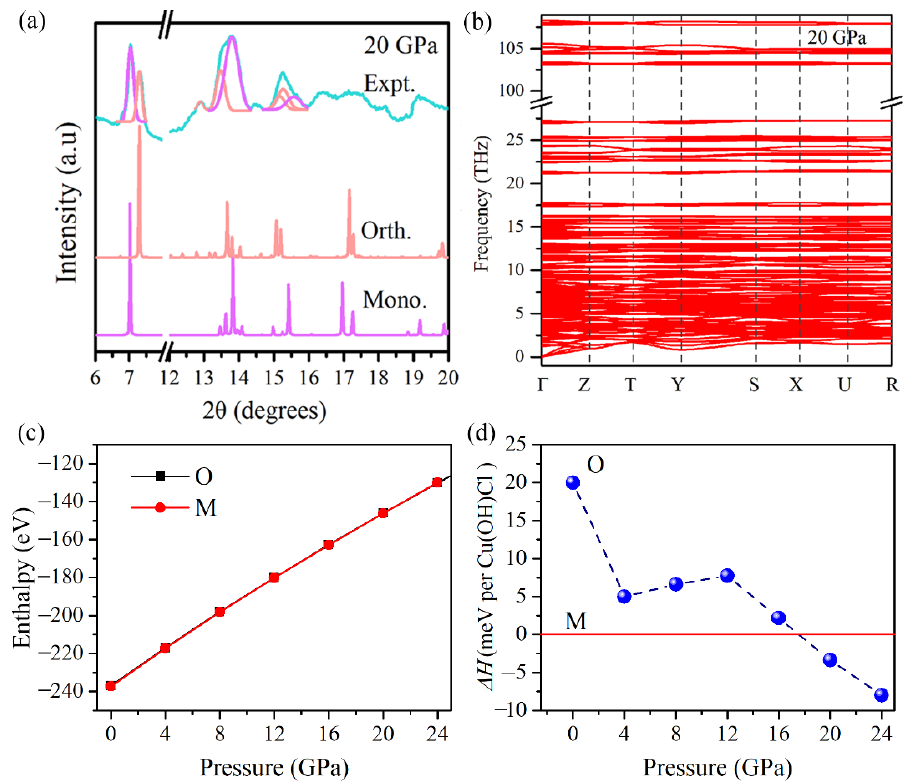
Figure 4. ( a ) The experimental and simulated XRD patterns of Cu(OH)Cl at 20 GPa with the two space groups, Pbn2 1 and P2 1 /a. ( b ) Phonon dispersions of the Pbn2 1 phase of Cu(OH)Cl at 20 GPa. ( c ) The calculated enthalpies of the initial monoclinic phase and the postulated high-pressure orthorhombic phase of Cu(OH)Cl. ( d ) The calculated relative enthalpies Δ H of the orthorhombic phase with respect to the monoclinic phase of Cu(OH)Cl under various pressures.